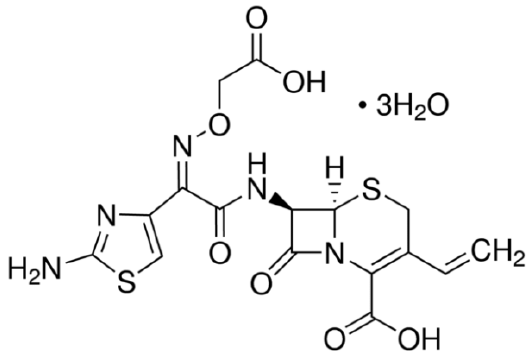
Figure 1. Chemical structure of CEF.